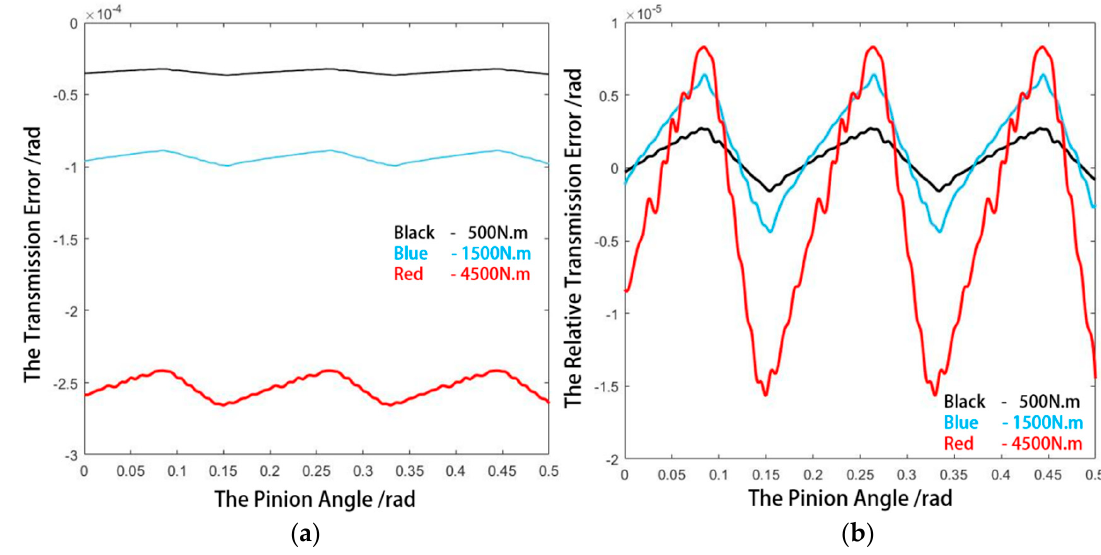
Figure 14. Comparison of transmission errors under different loads: ( a ) original transmission error curves, and ( b ) transmission error curves after translation.